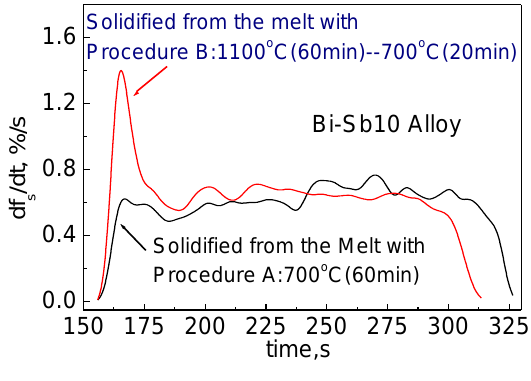
Figure 17. Bi-Sb10 T-t curves of different melts.